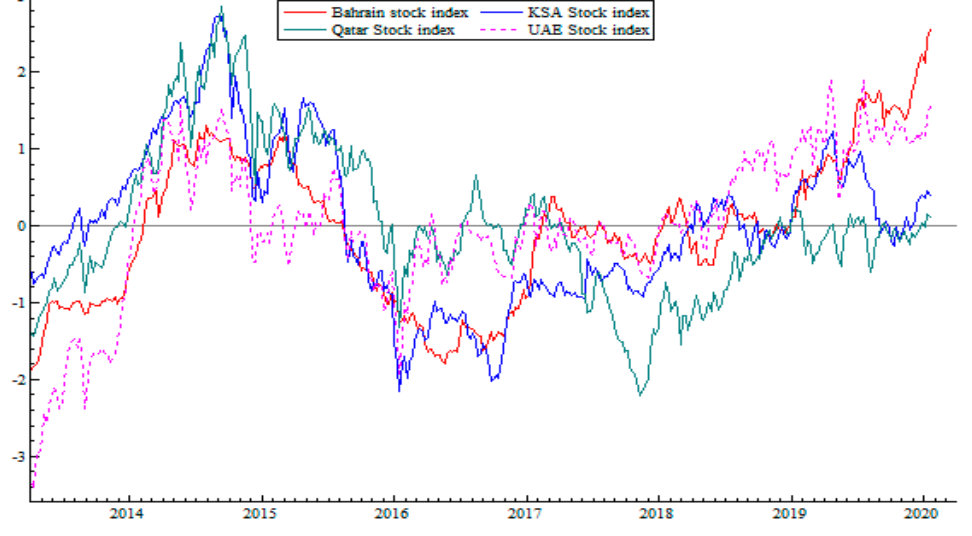
Figure 2. Time trend of the GCC stock market indexes.